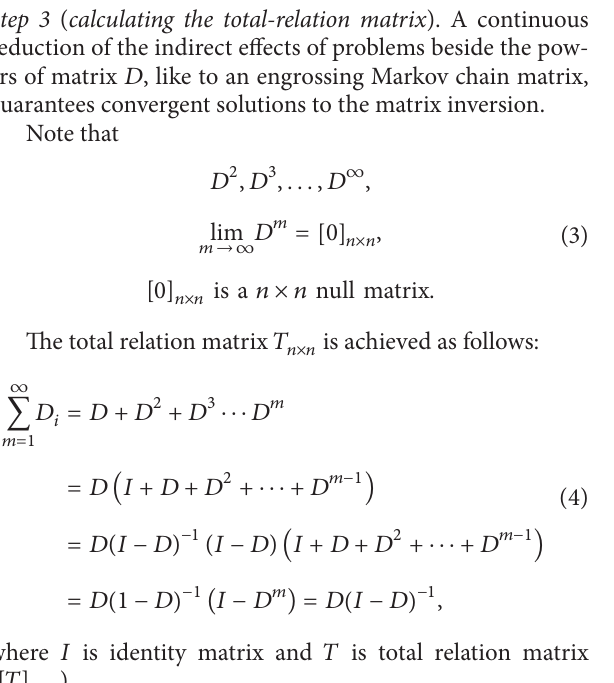
Table 4: Ranking dimensions based on 𝐼